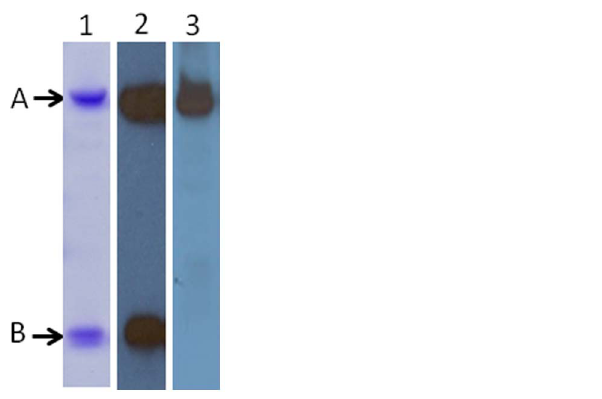
Figure 2. Reactivity of immunized rabbit serum IgG to Stx2a. Lane 1, Coomassie stained SDS-PAGE with 1 m g of purified Stx2a; lanes 2 and 3, Western blot of 0.5 m g of purified Stx2a probed with a mixture of mouse mAbs against Stx2 A- and B-subunits and rabbit 5154 serum IgG followed by horseradish peroxidase-conjugated goat secondary antibodies against mouse or rabbit IgG. The A and B subunit positions are indicated by arrows.